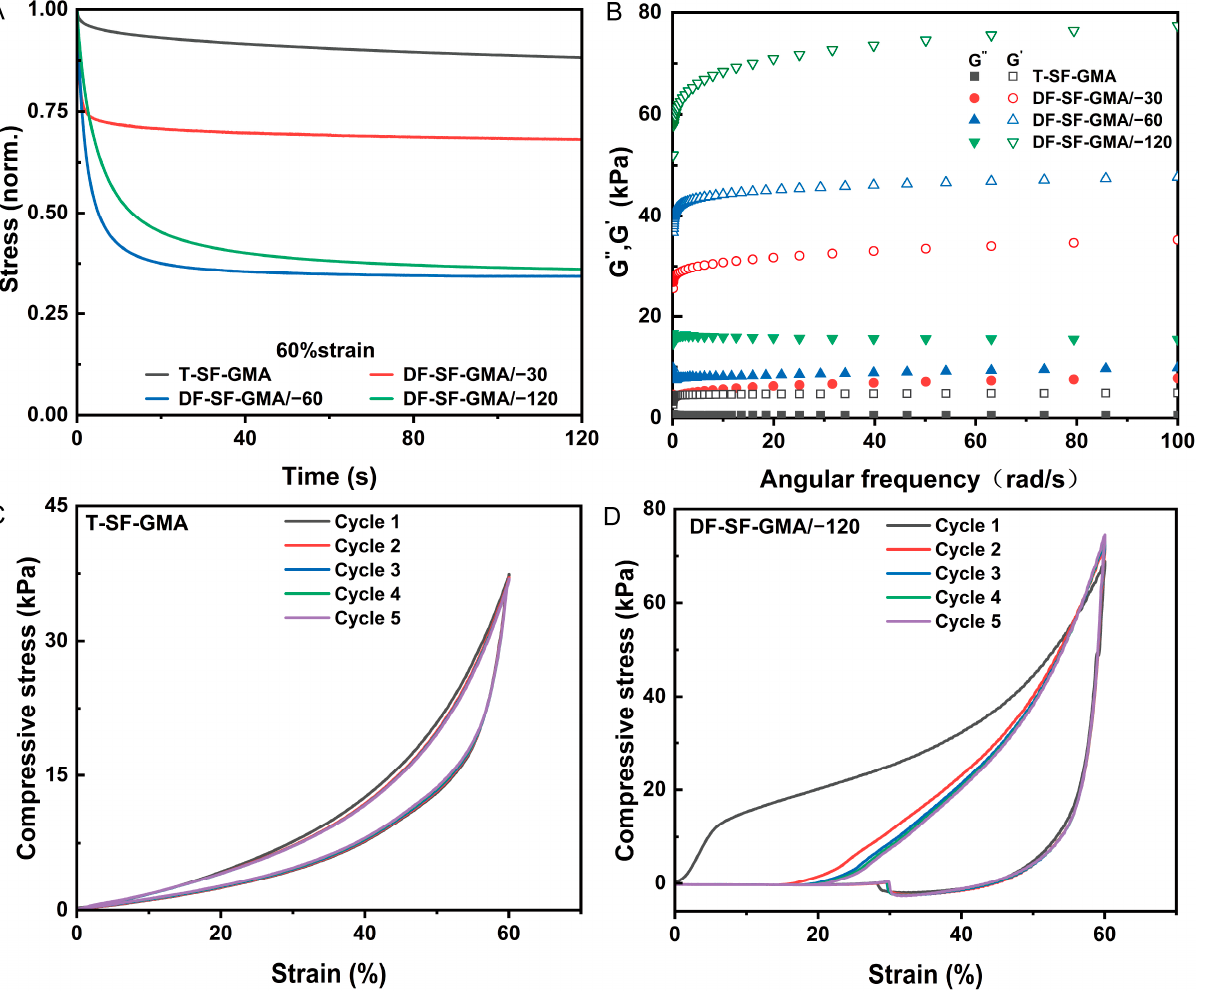
Figure 5. Viscoelastic properties of the T-SF-GMA and DF-SF-GMA hydrogels. ( A ) Stress relaxation test of the T-SF-GMA and DF-SF-GMA hydrogels at 60% strain. Stress is normalized by the initial stress. ( B ) Storage modulus and loss modulus of the T-SF-GMA and DF-SF-GMA hydrogels were tested using a rheometer at different frequencies. Cyclic compression test of the T-SF-GMA ( C ) and DF-SF-GMA/ − 120 ( D ) hydrogels under 60% strain.